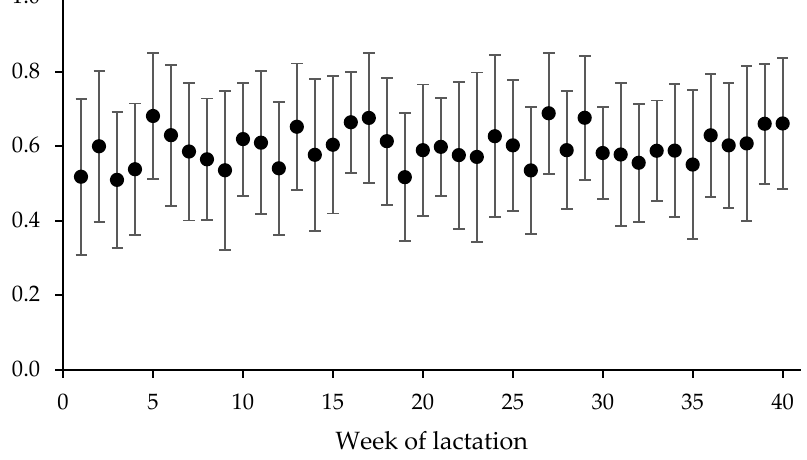
Figure 4. Rank correlation of CH 4 emissions (with s.e. bars) in grams per kg milk across lactations.